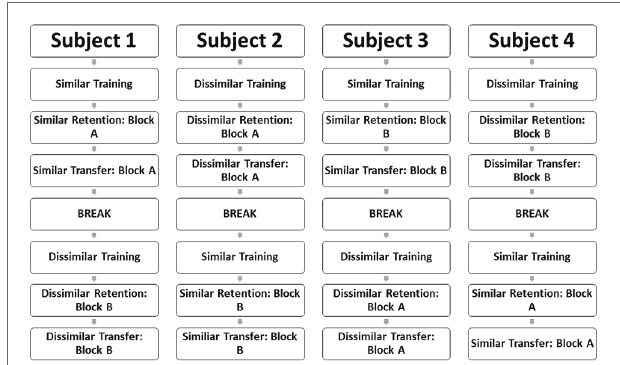
FIGURE 1 | Schematic depiction of the nonword repetition task across participants using a cross-over